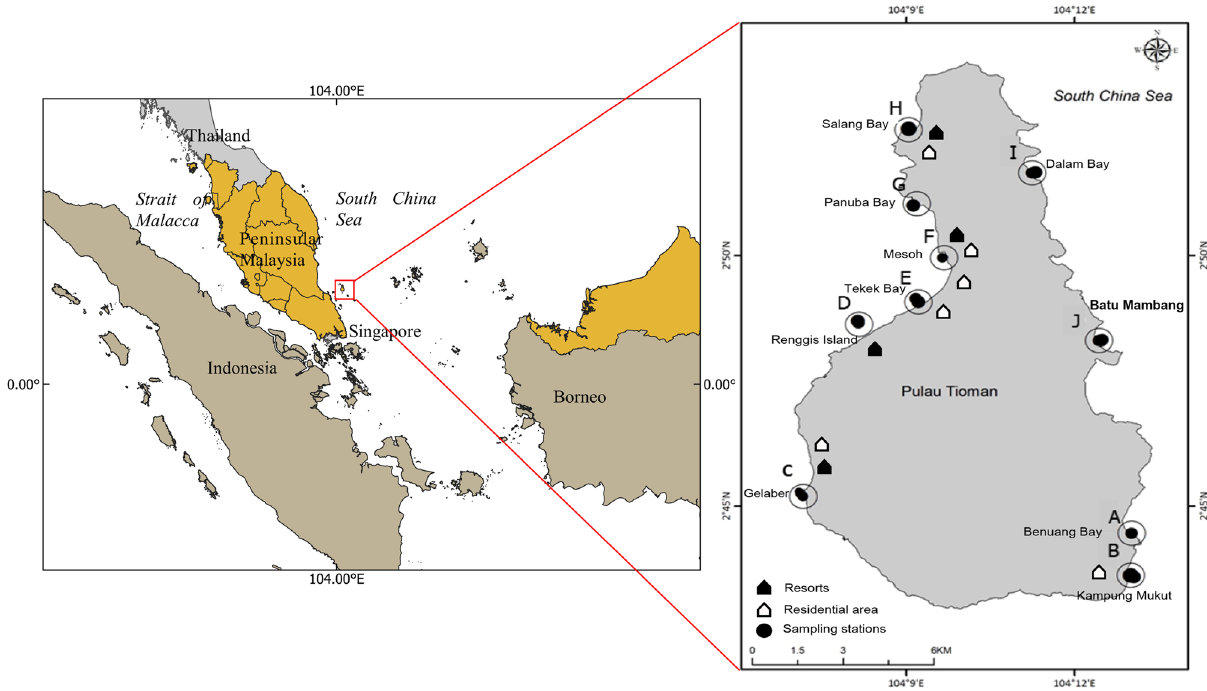
Figure 5. The study area shows ( A ) the map of Peninsular Malaysia with a box marking Tioman Marine Park. ( B ) The distribution of sampling stations, resorts, and residential areas on the east and west coast of Pulau Tioman, Malaysia. (Map produce using the Free and Open Source QGIS